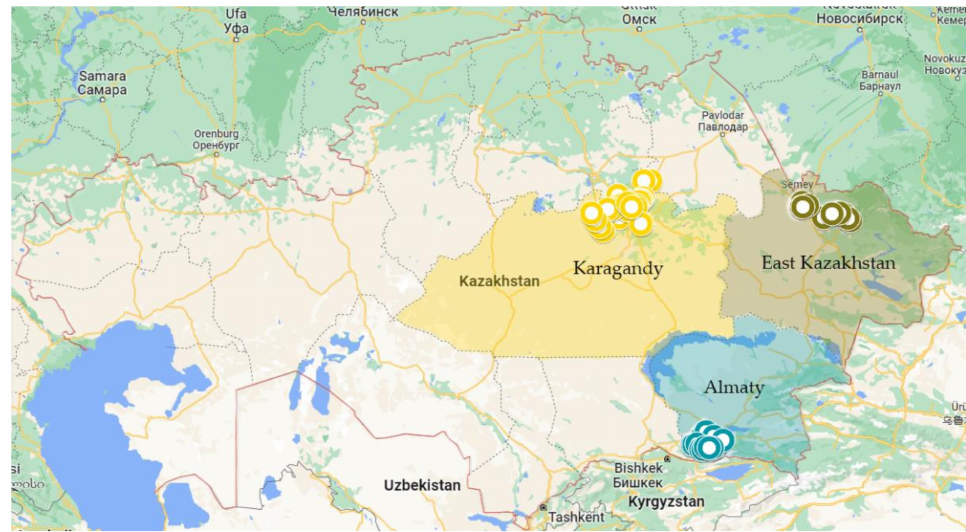
Figure 1. Map of the Republic of Kazakhstan showing the different agro-geographical regions and sampling sites during July